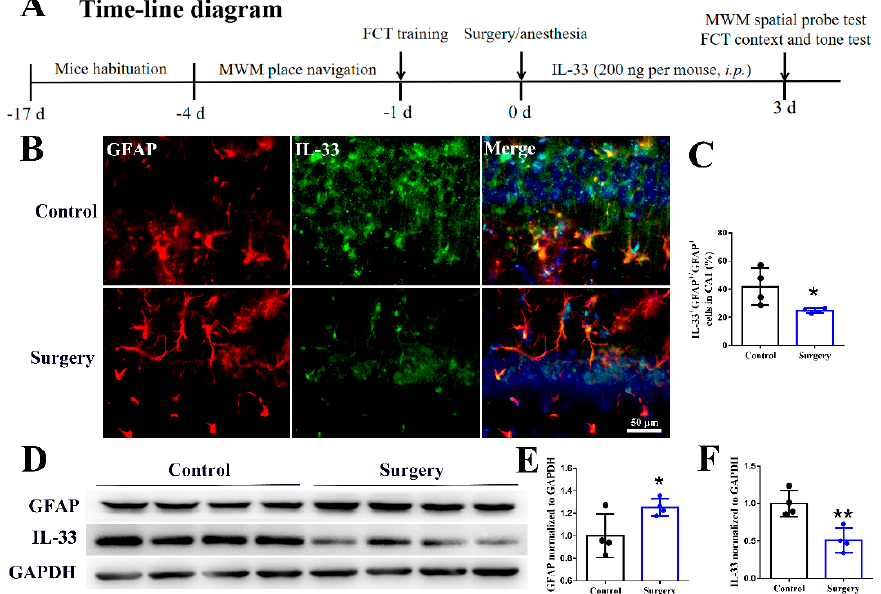
Figure 1. Surgery/anesthesia decreases the hippocampal astrocyte-derived IL-33. Timeline of the study ( A ). The levels of IL-33 and GFAP were detected by immunofluorescence ( B , C ) and Western blot ( D – F ), respectively 3 days after surgery. Data are expressed as the mean ± SD (two-tailed unpaired t -test, n = 4 per group). * p < 0.05 and ** p < 0.01 versus the control group .